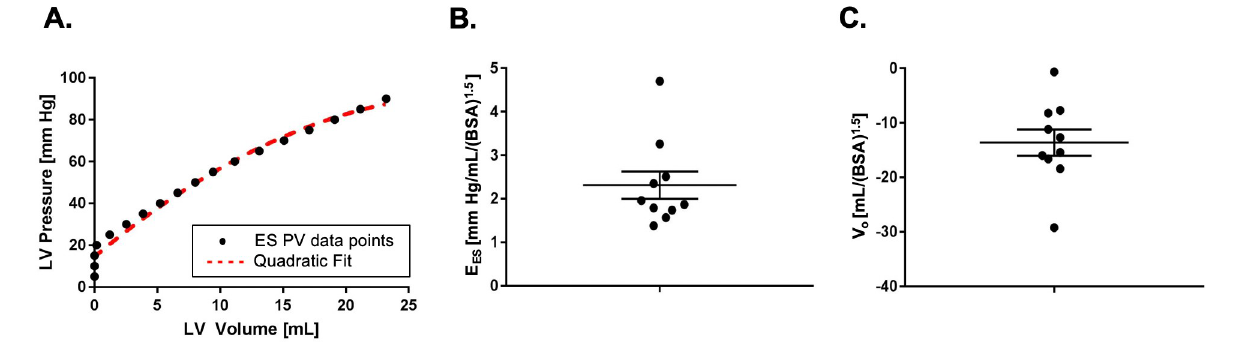
Fig 9. Representative ESPVR with a quadratic fit in red dashed line (A) . End-systolic elastance E ES,Index (B) and volume intercept V o,Index (C) of ESPVR indexed to body surface area.